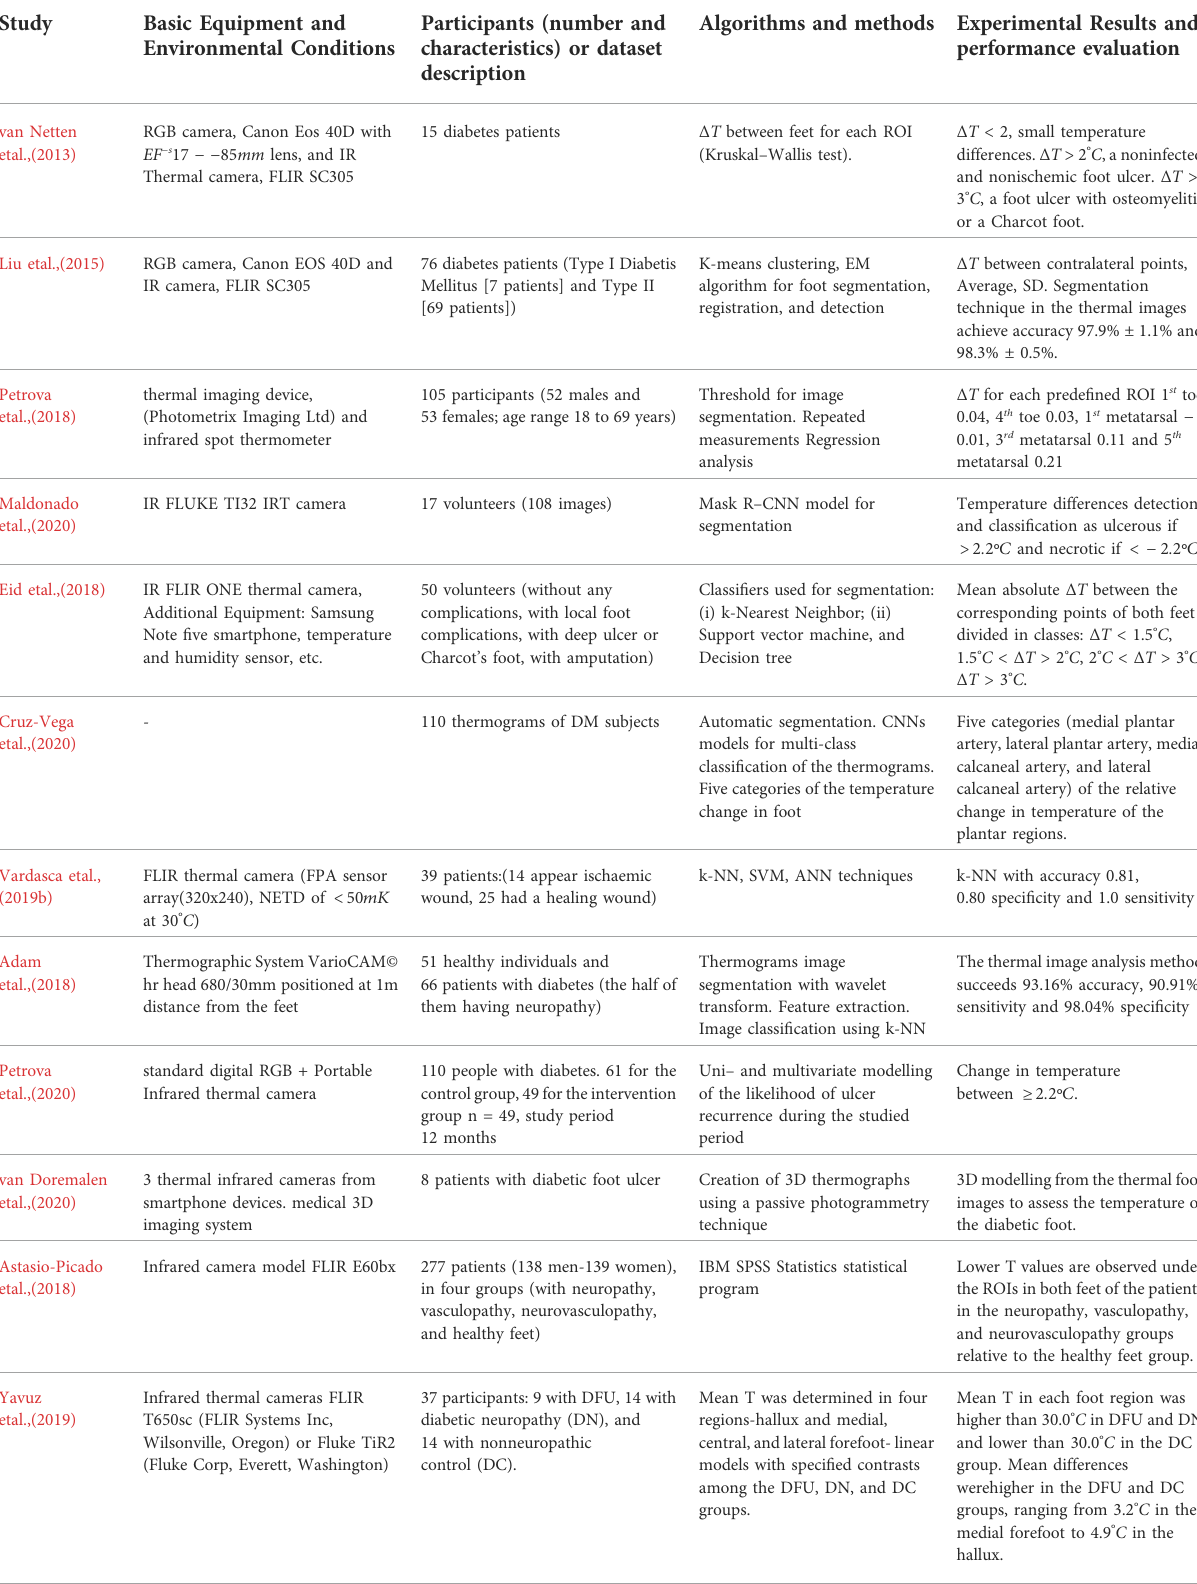
TABLE 6 Summary of the literature for diabetic foot monitoring using imagery data from thermal